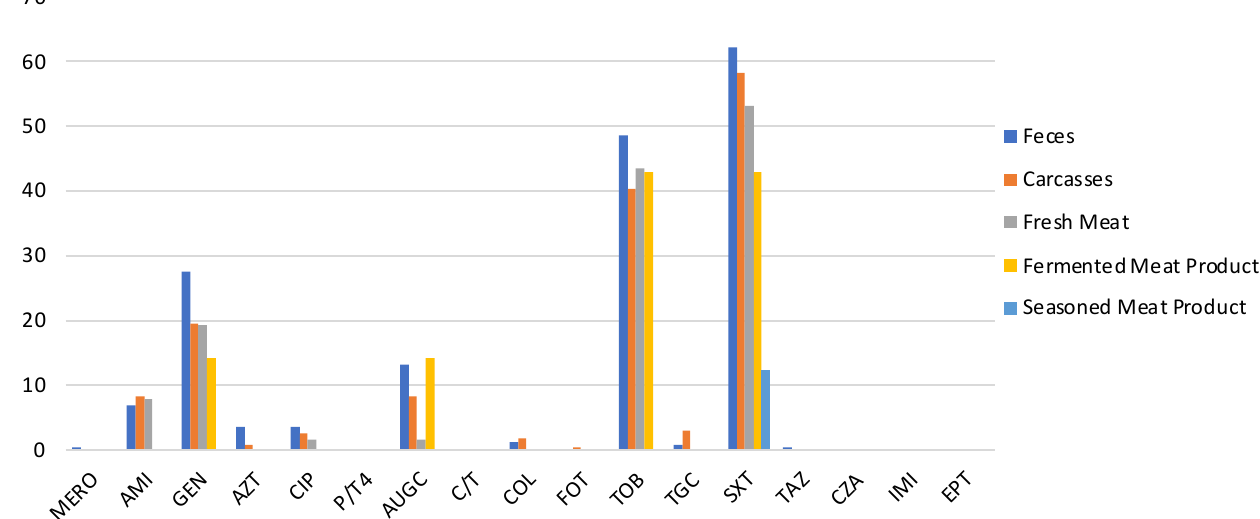
Figure 1. Prevalence of antimicrobial-resistant E. coli isolated from feces, carcasses, and meat products. (MERO = meropenem, AUGC= amoxicillin/clavulanic, C/T4 = ceftolozane/tazobactam, FOT = cefotaxime, TAZ = ceftazidime, CZA = ceftazidime/tazobactam, IMI = imipenem, ETP = ertapenem, AZT = aztreonam, AMI = amikacin, GEN = gentamicin, TOB = tobramycin, CIP = ciprofloxacin, COL = colistin, TGC = tigecycline, SXT = sulphamethoxazole/trimethoprim). In particular, 62.1% (CI 95% = 56–68.2) of E. coli isolated from feces, 58.2% (CI 95% = 51.8–64.6) of carcasses strain, and 48% (CI 95% = 36.8–59.2) of pork meat products E. coli were resistant